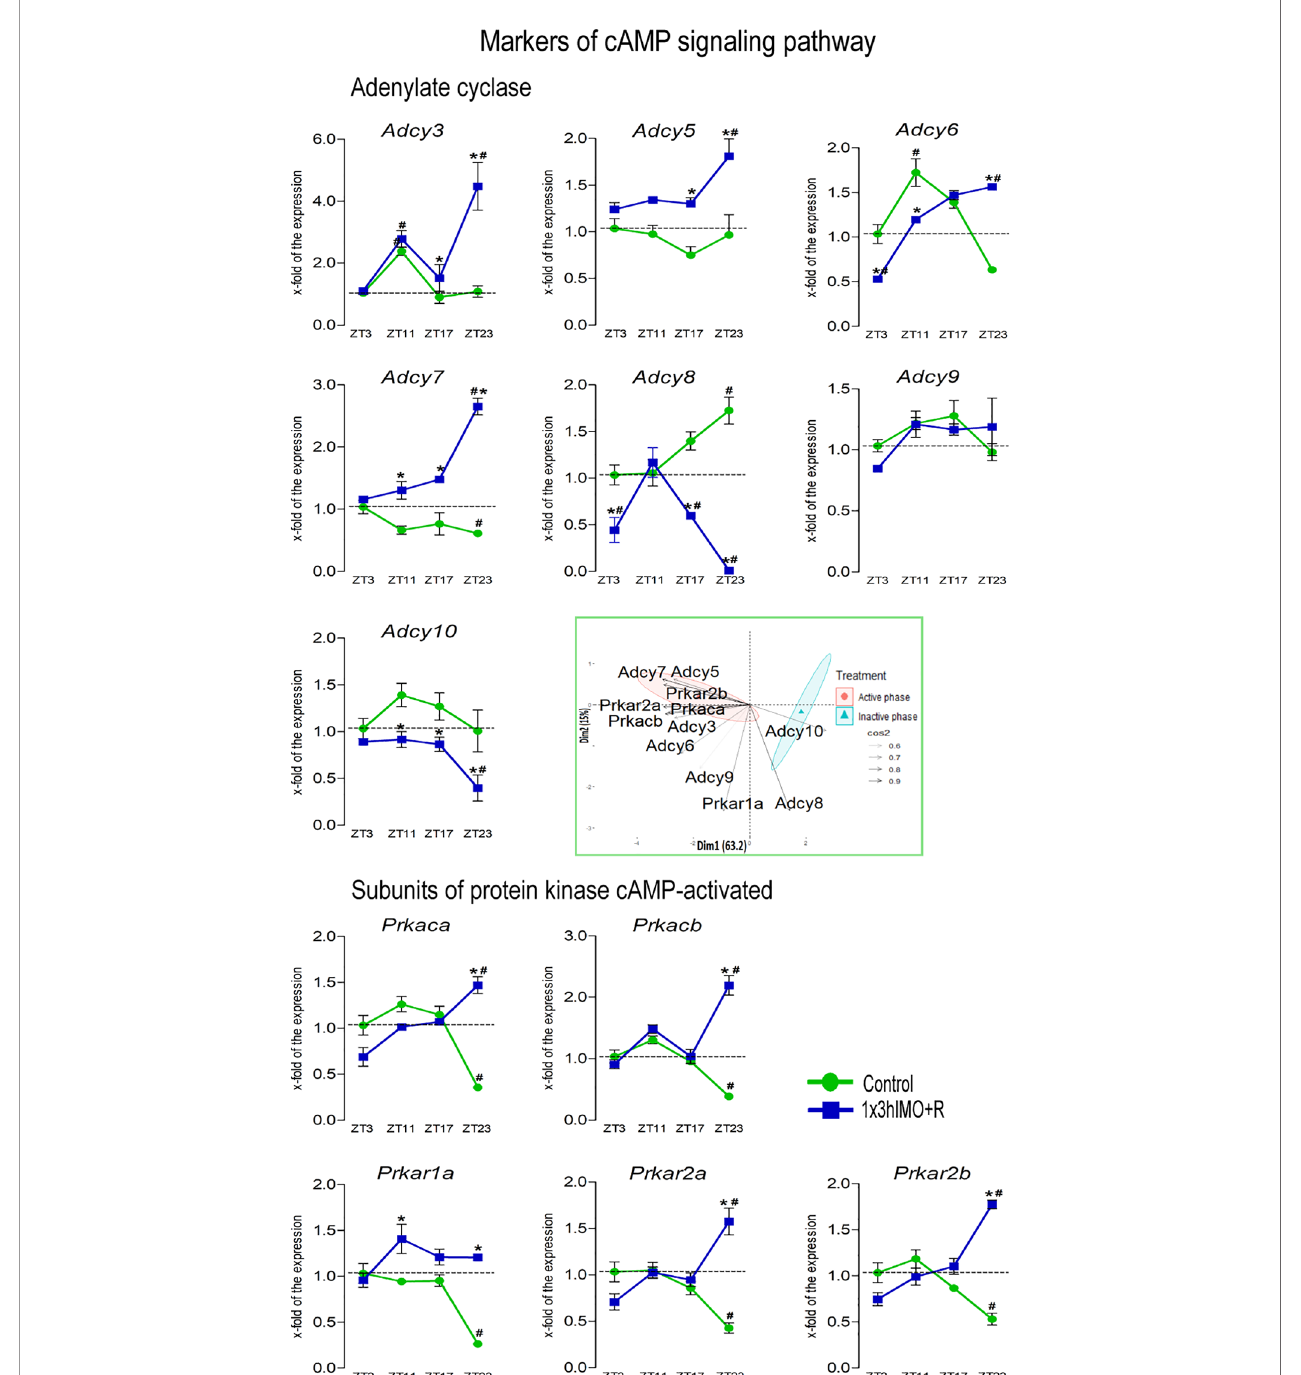
FIGURE 8 | Transcription of markers of cAMP signaling regulating mitochondrial dynamics and functionality as well as spermatozoa number and functionality is changed in spermatozoa of acutely stressed adult rats in a time-dependent manner. Isolated RNA from spermatozoa of undisturbed and stressed rats was used for the analysis of the transcriptional pro fi le of markers of the cAMP signaling pathway. PCA of markers of the cAMP signaling pathway on active/inactive phase; Dim1 and Dim2 represent the fi rst two PCs and % of the retained variation. Cos2 estimates the qualitative representation of variables ( Supplementary Table S2 ). Data are presented as green dots connected with a green line for the control group, and blue squares connected with a blue line for the 1x3hIMO group, and are mean ± SEM values of two independent in vivo experiments. Statistical signi fi cance was set at p < 0.05: * vs. the control group of the same time point, # vs. the control group of ZT3 time point.